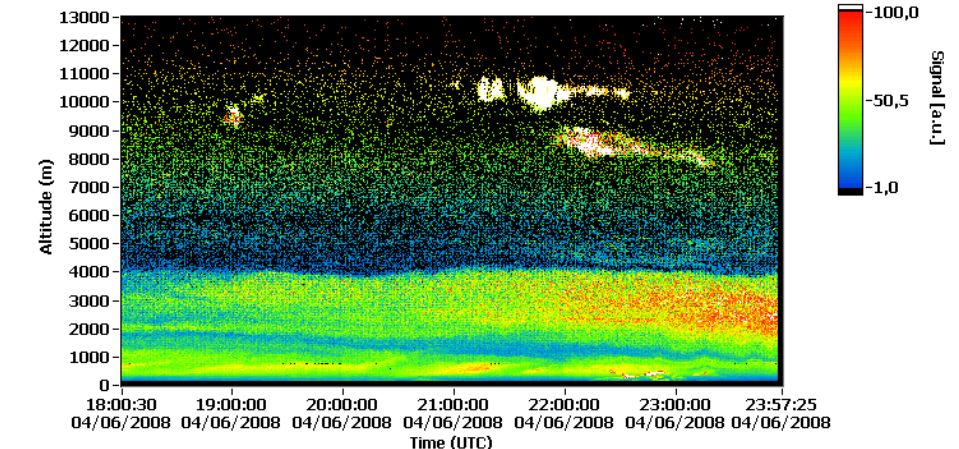
Figure 2. An example backscatter time series at 1064 nm wavelength in Gual Pahari on Fig. 2. An example backscatter time series at 1064nm wavelength in Gual Pahari on 4 June 2008. June 4, 2008. these, the system is equipped with airplane radar that shuts down the laser in case an airplane is detected. The radar is constructed by following the main guidelines presented by Duck et al.